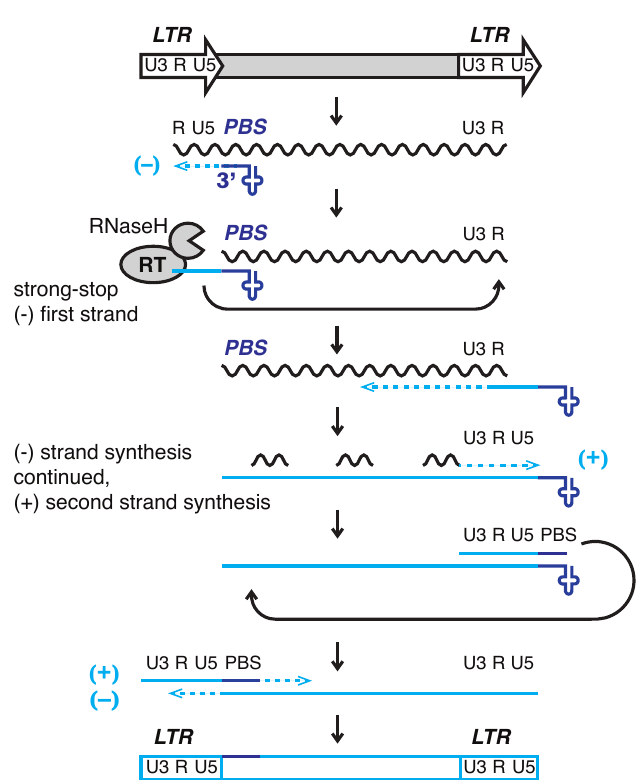
Figure 1. Model of reverse transcription of long terminal repeat (LTR)-retrotransposons and -viruses. LTRs encode promoter elements and termination signals. The RNA transcript contains a region repeated at either end (R), a 5 (cid:48) unique segment (U5), and a segment only included at the 3 (cid:48) -end of the RNA (U3). The 3 (cid:48) -end of cellular tRNAs (blue cloverleaf) primes reverse transcription by hybridizing to the primer binding site (PBS). While this segment is being copied into first-strand cDNA (light blue line), also called minus ( − ) strong stop DNA, the RNaseH activity of reverse transcriptase (RT) degrades the template RNA. The elongating cDNA is transferred to the 3 (cid:48) -end of the retrotransposon transcript hybridizing to the R region. The remaining RNA is partially degraded by RNaseH leaving behind primers for second-strand, plus ( + ) cDNA synthesis. In Retroviridae , the plus strand PBS is a copy of the tRNA primer, while the minus strand is a copy of the original PBS sequence. After another transfer event, first ( − ) and second ( + ) strand synthesis are completed to result in a full-length, double-stranded retroviral DNA that will be integrated into the host